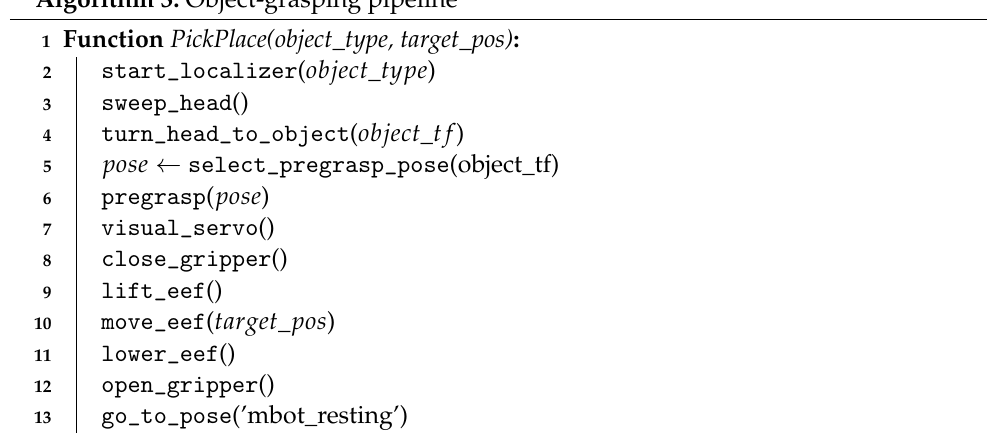
Algorithm 3: Object-grasping pipeline